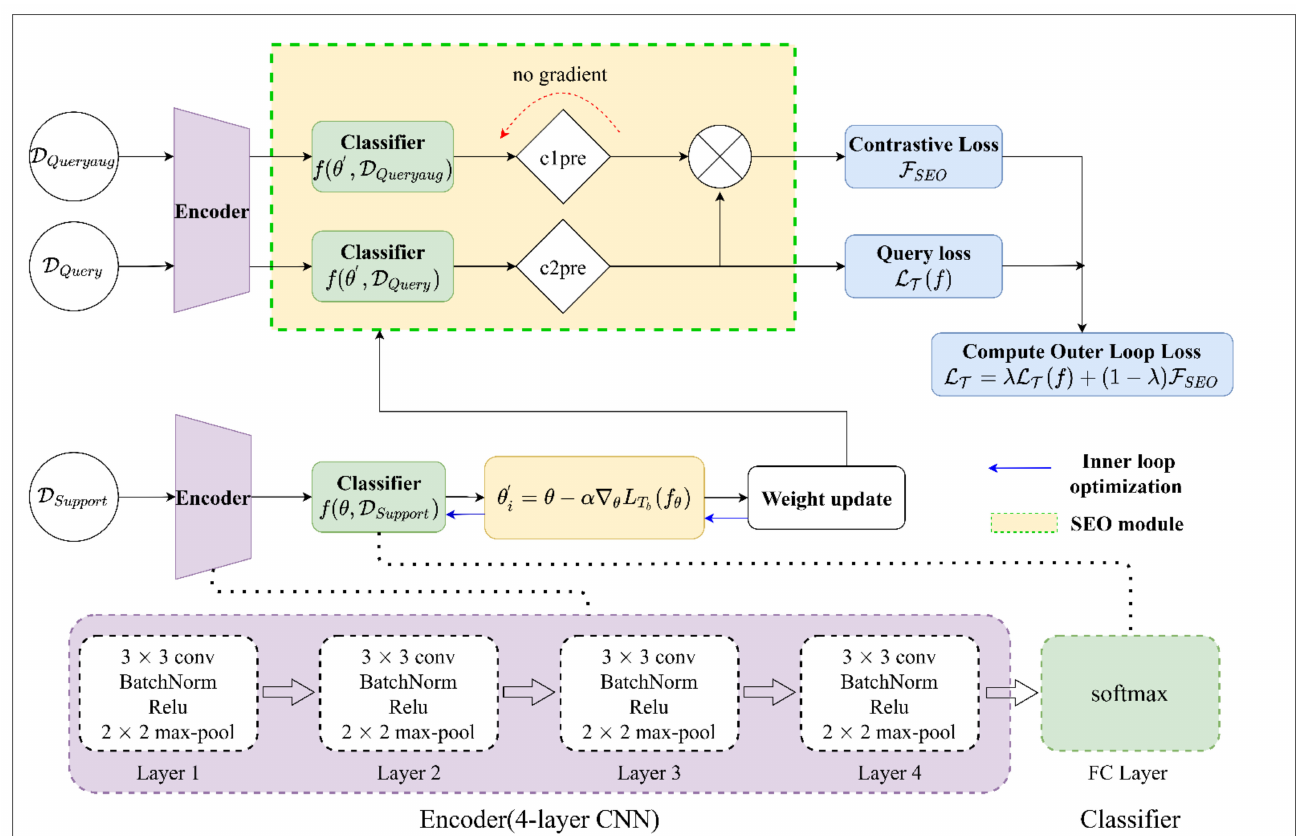
Figure 2. The proposed Meta-FSEO. Starting from the lower-left corner, the divided support dataset first passes through a backbone encoder and classifier (encoder represents a 4-layer CNN and classifier represents a classification output result) and updates θ to θ i through an internal optimization of meta-learning. We pass the D Query set and D Queryaug set (after data enhancement) into our self-supervised embedding optimization module for the next update (diamond represents the prediction result, a cross in a circle represents Equation (3)), combine contrast loss and the cross-entropy loss to obtain the final loss function, and perform external optimization. The encoder is composed of a four-layer convolutional network structure that contains a 3 × 3 convolution with 48 filters, followed by batch normalization with momentum set to 0.1, a ReLU nonlinearity, a 2 × 2 max-pooling, a linear layer, and a SoftMax layer. The padding and stride are both set to 1, except for the 2 × 2 max-pooling, whose stride and padding are set to 2 and 0, respectively. In batch normalization, the momentum is set to 0.1. The epsilon, a value in the denominator for numerical stability, is set to